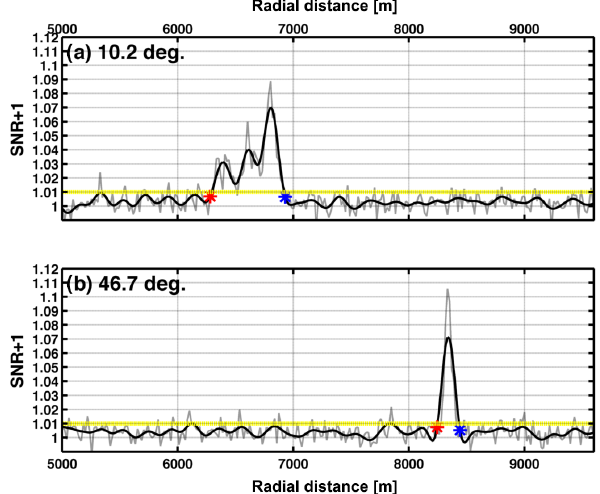
Figure 2. Examples of the plume detection and attenuation algo- rithm based on the filtered (solid black line) and unfiltered (gray line) lidar signal-to-noise ratio (SNR + 1). (a) Low elevation angle (10.2 ◦ ) lidar beam intersecting the base of the Bald Fire convective column. (b) High elevation angle (46.7 ◦ ) beam intersecting the py- roCu in the upper plume. The red stars indicate the leading plume edge and the blue stars the attenuation point. The SNR + 1 threshold of 1.01 is indicated with a dashed yellow